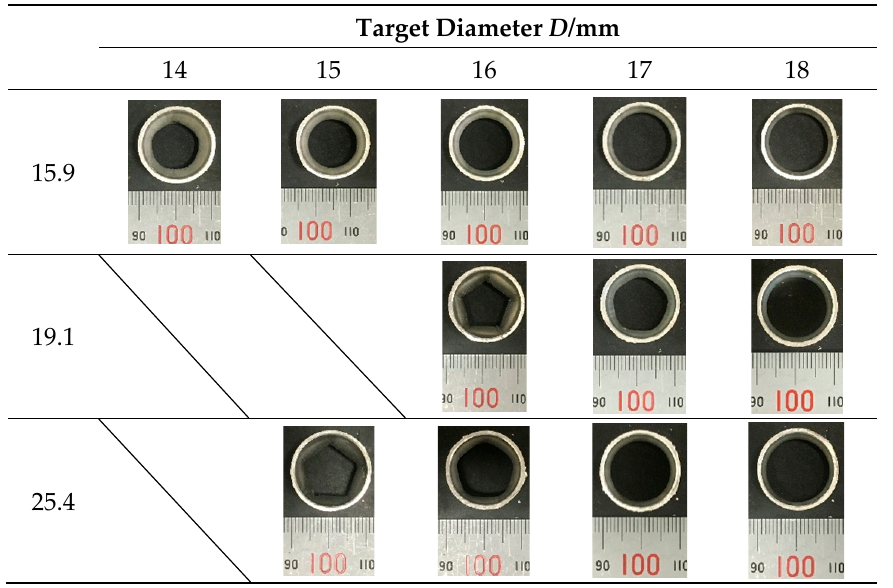
Figure 13. Appearance of formed tube when f R = 0.042 mm/rev. Table 3. Cross-section of formed tube when f R = 0.042 mm / rev. Table 3. Cross-section of formed tube when f R = 0.042 mm/rev.